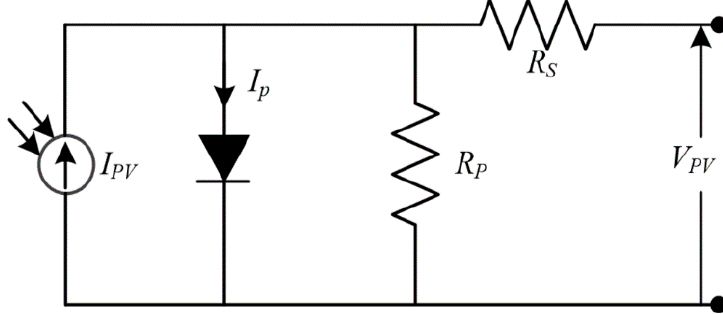
Figure 4. Solar PV equivalent